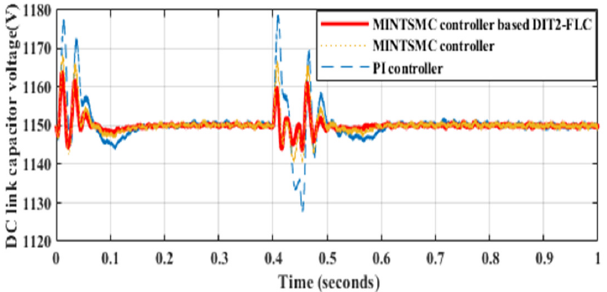
Figure 10. The voltage of the DC link capacitor in the DFIG system for scenario I via the PI controller, MINTSMC controller, MINTSMC controller-based DIT2-FLC.